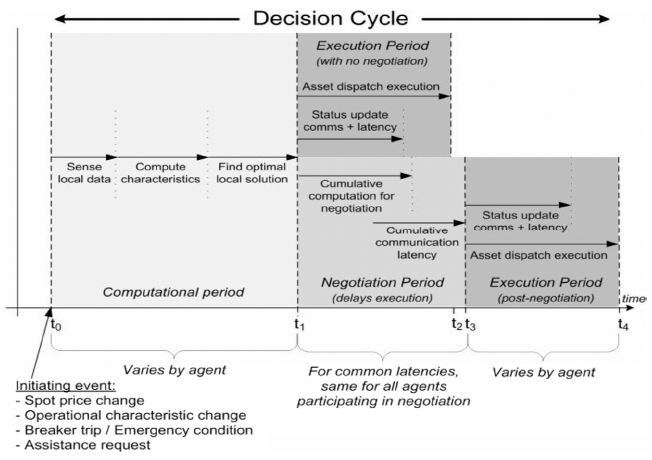
Figure 6. Agent decision cycle .